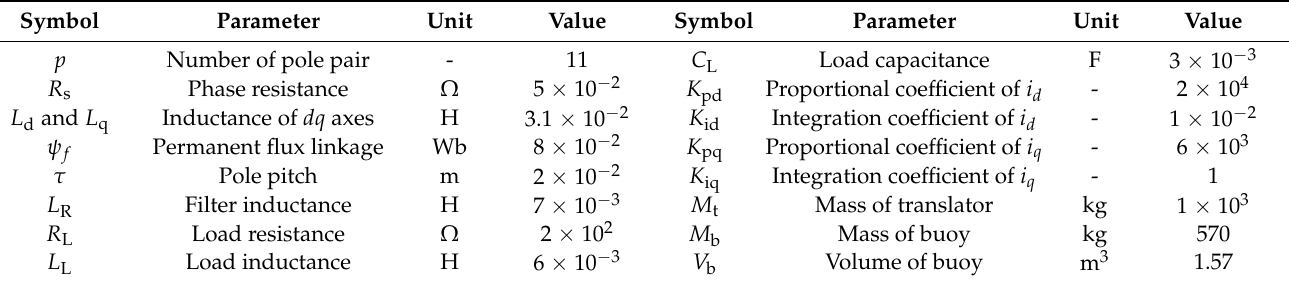
Figure 9. Responses of DDWEC when hydrodynamic parameters change and keep constant. ( a ) Translator position; ( b ) Wave excitation force. Table 1. Parameters in UDDWEC